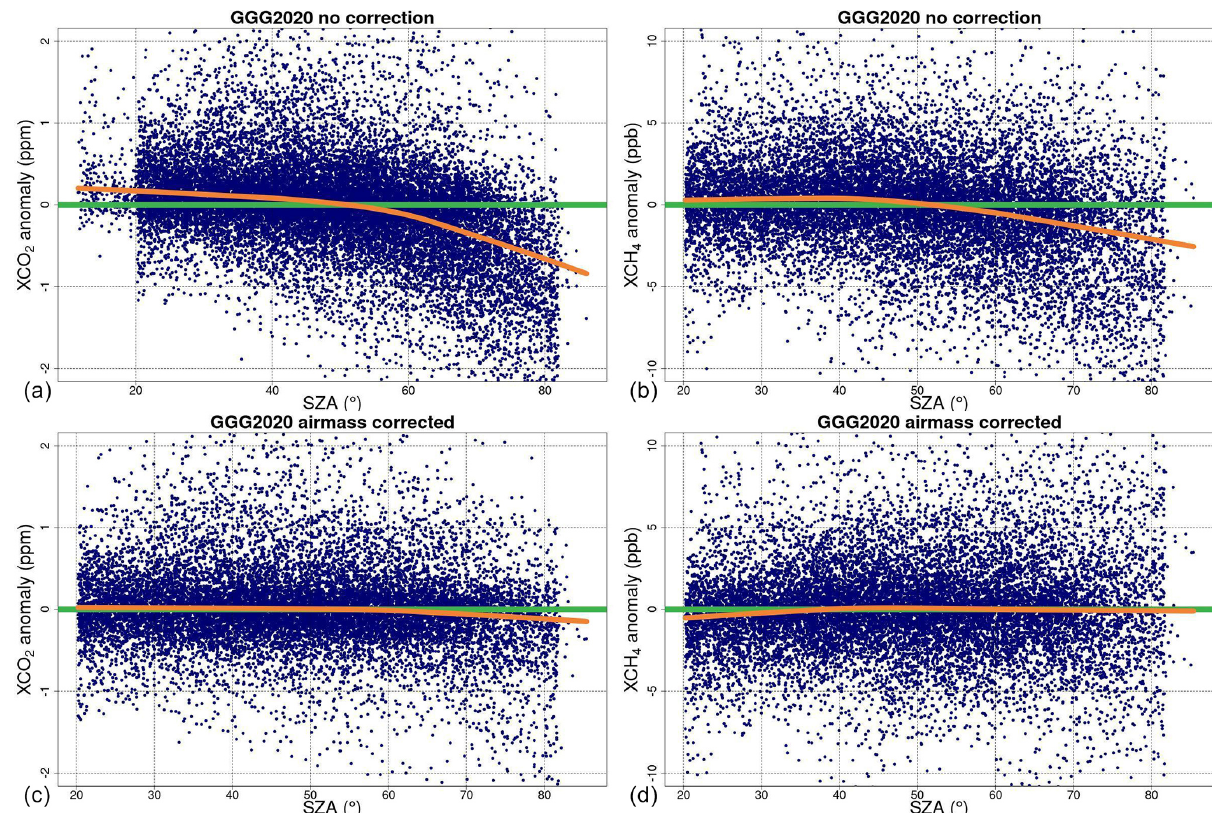
Figure 5. Daily XCO 2 and XCH 4 anomalies of the EM27/SUN (ta) measured in Toronto from 2017 to 2021 and during the road trip in 2018 vs. solar zenith angle using GGG2020. (a, b) No ADCF applied. (c, d) The derived ADCF for the EM27/SUN devices are applied. The orange line is the Lowess curve fit. The horizontal green line is the y = 0